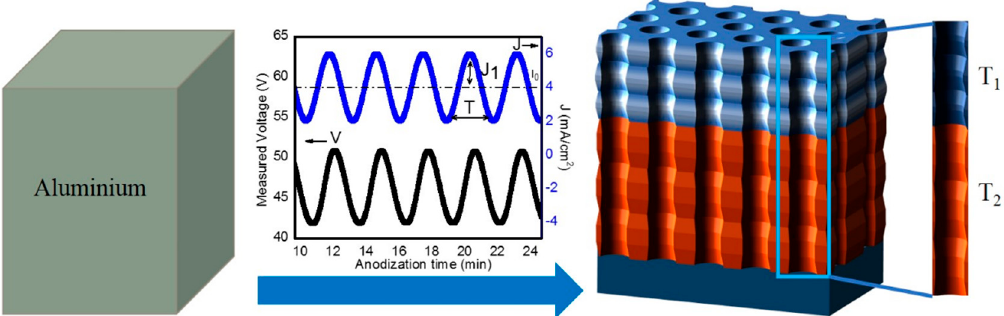
Figure 1. Schematic representation of the electrochemical strategy applied to produce the nanoporous anodic alumina gradient-index filters (NAA-GIFs) through sinusoidal anodization. J 1 represents current density amplitude, I 0 represents offset current density, V and J correspond to measured voltage and applied current density respectively, T is the time period of the sinusoidal variation. T 1 and T 2 represent the time periods used to obtain the two rugate structures that together form the NAA-GIFs in this study.